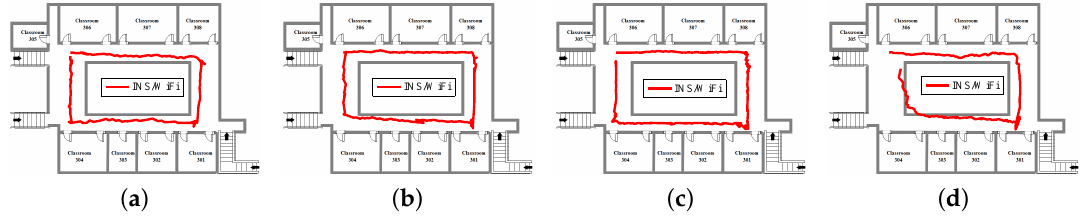
Figure 7. Positioning results for INS/WiFi: ( a ) calling; ( b ) dangling; ( c ) handheld; and ( d ) pocket.